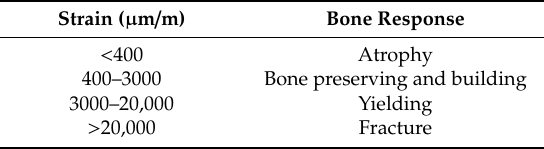
Table 2. Values set for bone thresholds and response to particular strain rates [32,33].